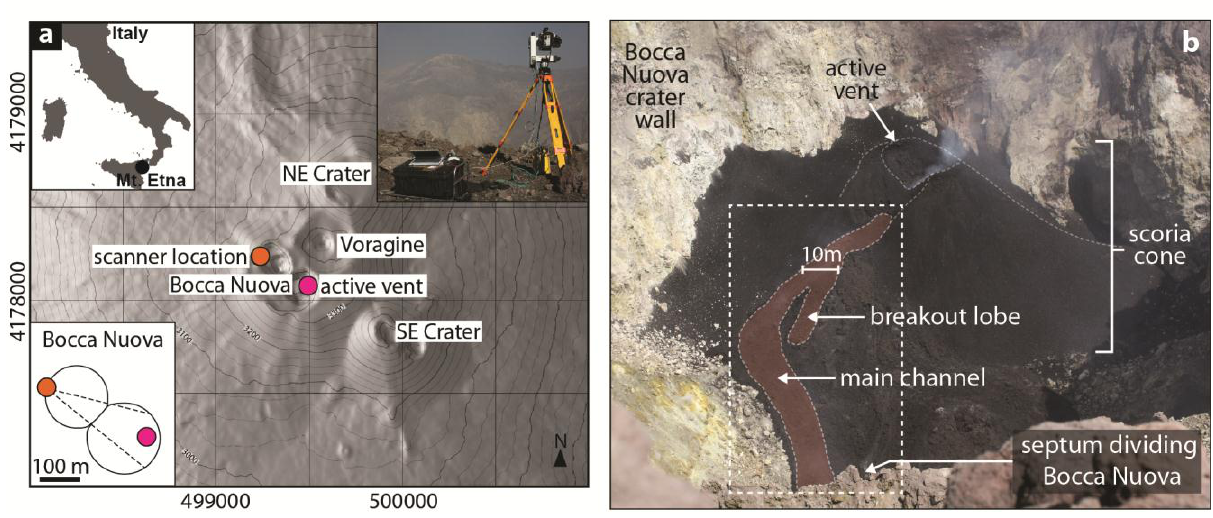
Figure 1. Etna summit craters and the July 2012 activity. ( a ) Summit map showing the four active craters, NE Crater, SE Crater, Bocca Nuova and Voragine, along with the scan site and location of the active vent within Bocca Nuova. Coordinates are in UTM Zone 33N. The top left inset gives the location of Mount Etna. The top right inset shows the TLS instrument at the crater rim. The lower left inset illustrates the twin-crater nature of the Bocca Nuova and the approximately southeast-looking TLS/camera view (dotted lines) of the active vent shown in the photograph ( b ). The photograph (taken from the scan site, 21 July, 15:00, with a 28-mm lens) shows the scoria cone topped by the active vent and surrounded by associated deposits, represented by the dark region covering the central ~50% of the image. The dashed box outlines the scan window used to capture the 10-minute interval lava flow TLS